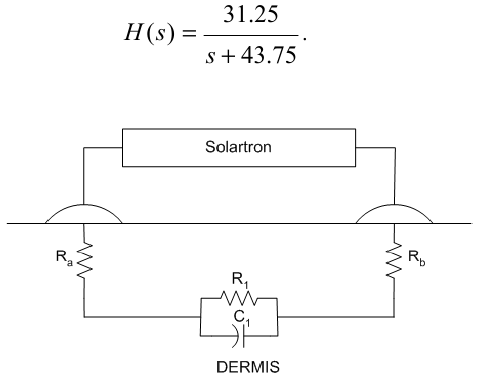
Fig. 2: Equivalent electrical circuit to the first layer of the model.